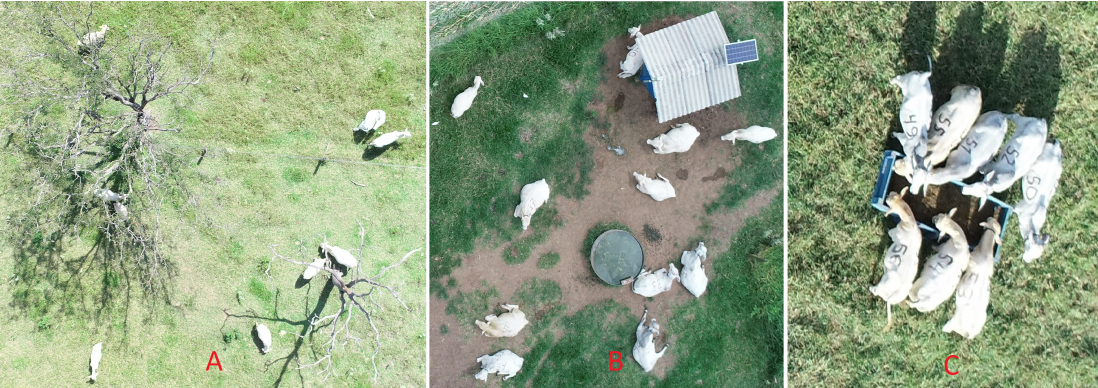
Figure 6. Examples of images containing trees ( A ), shed ( B ) and feeder ( C